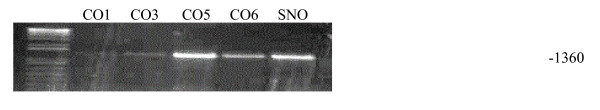
RT-PCR analysis of ILK expression in HOSCCs. RT-PCR was performed using specific primers co-amplifying ILK1 and ILK2. PCR products in the HOSCC cell lines WHCO1, WHCO3, WHCO5, WHCO6 and SNO separated on 2% agarose gels and stained with ethidium bromide. (A) An ILK band of 1360 bp was amplified across all five cell lines. 1 kb ladder in lane 1.